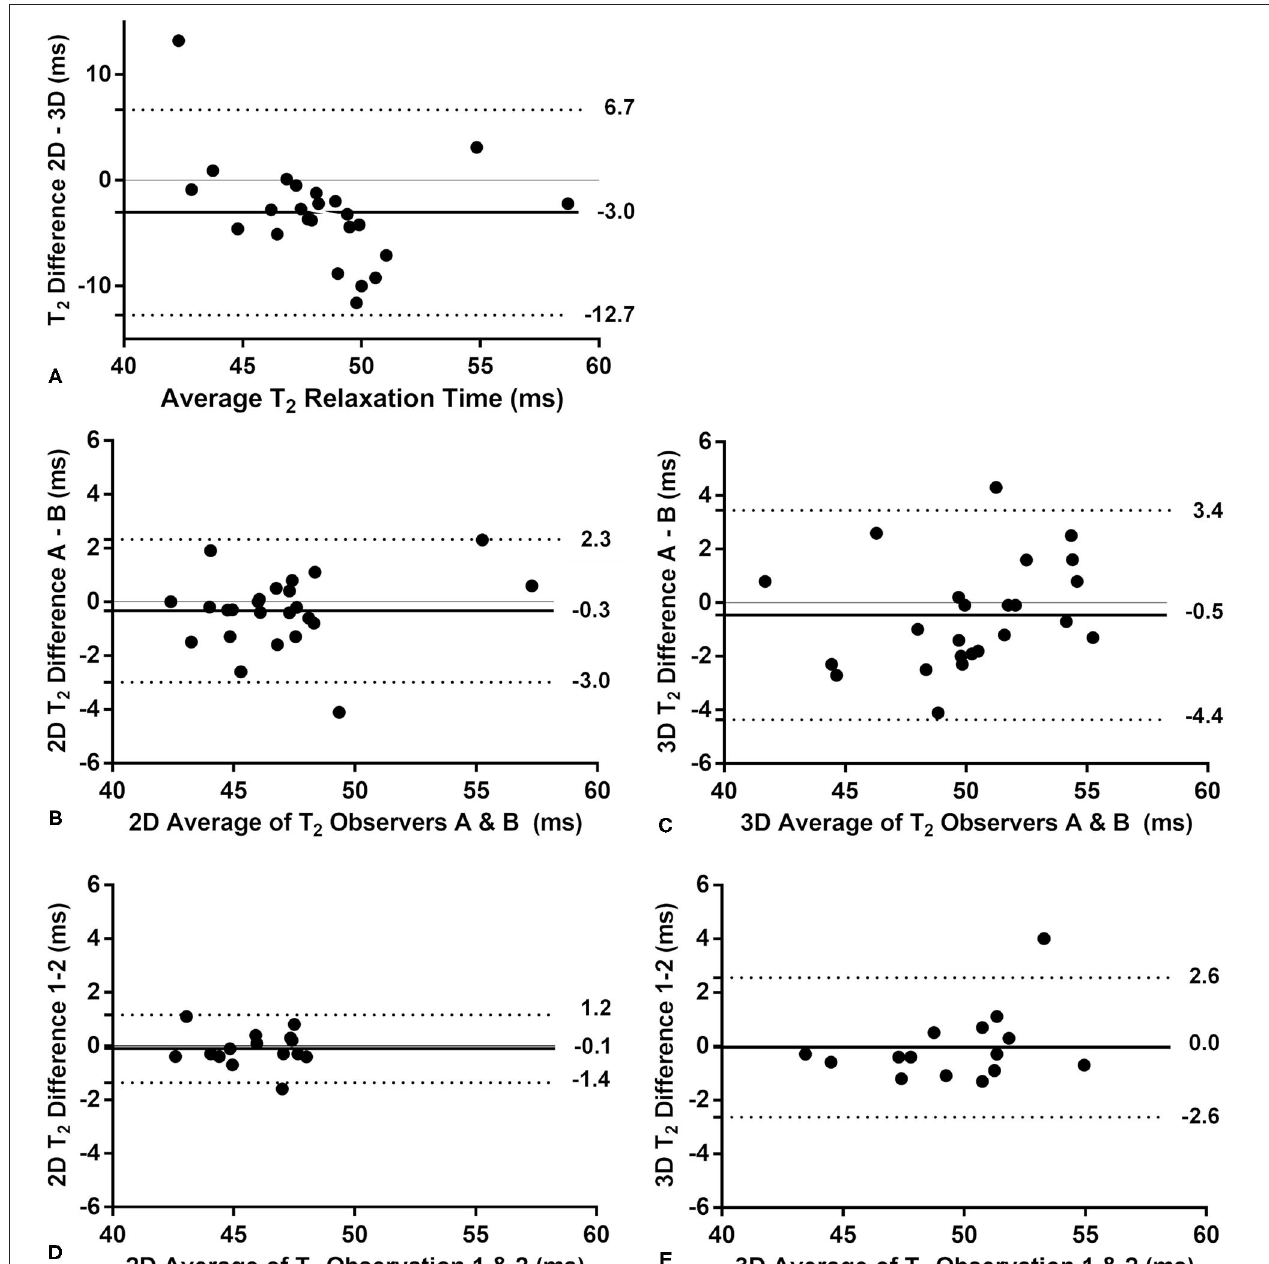
FIGURE 5 | Bland-Altman analyses of the 2D vs. the 3D T 2 mapping technique in the patients. The bias is indicated with a solid line, while the upper and lower limits of the 95% confidence interval are indicated with a dotted line. (A) The comparison of the 2D and 3D techniques shows a small bias, but no significant trend ( P = 0.11 for a linear correlation). (B) The interobserver comparison for the routine 2D technique indicates a very small bias and small confidence interval. (C) The interobserver comparison of the 3D technique has a similarly small bias and a slightly larger confidence interval than the 2D technique. Neither interobserver plot shows a significant trend ( P > 0.21). The intra-observer analysis performed in a subset of patients ( n = 15) showed no bias or trend for the 2D (D) and 3D (E) techniques, although the confidence interval for the 3D technique was twice as large as that of the 2D technique.